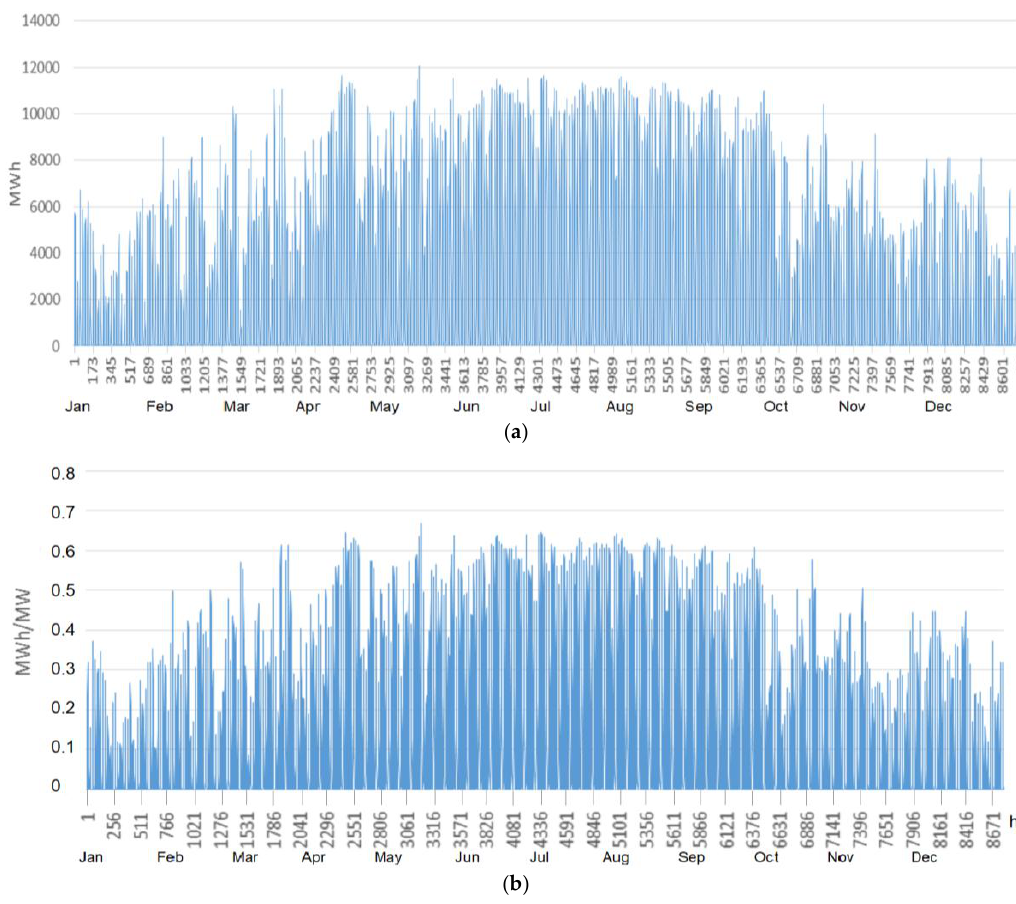
Figure 6. ( a ) Hourly photovoltaic production trend and ( b ) specific photovoltaic hourly distribution in Italy.